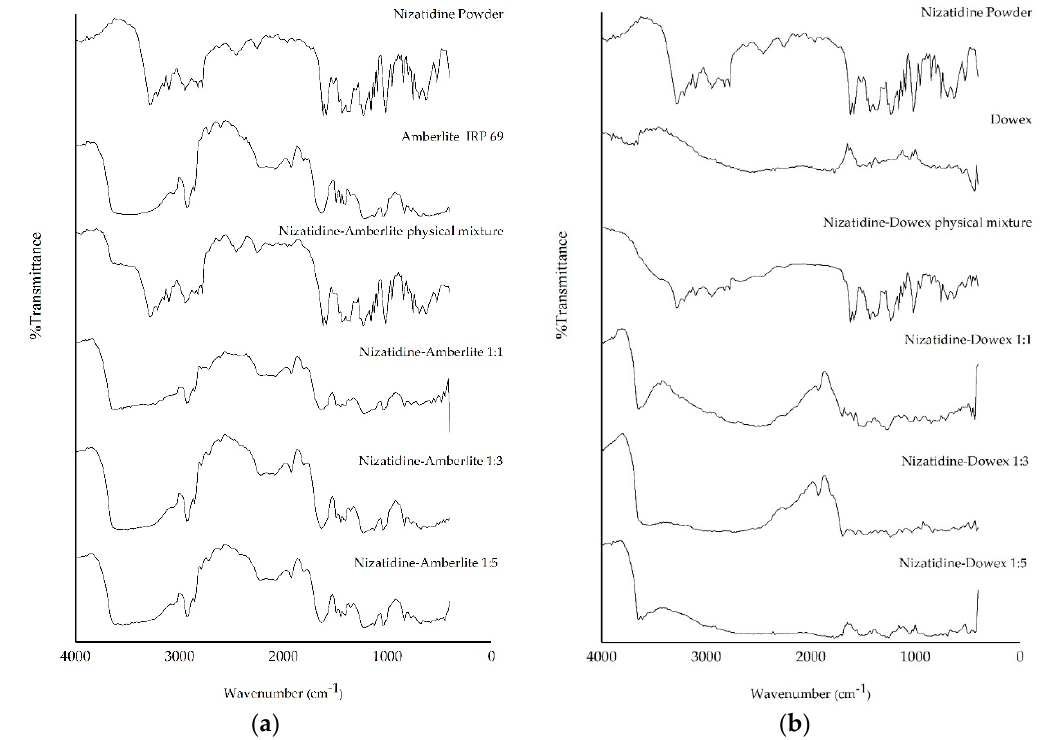
Figure 3. Fourier-transform infrared spectroscopy (FTIR) spectra of NZD powder, Amberlite IRP-69 resin, a physical mixture of NZD and Amberlite and the NZD-Amberlite complex at ratios of 1:1, 1:3, and 1:5 ( a ) and NZD powder, Dowex 50w resin, a physical mixture of NZD and Dowex and the NZD-Dowex complex at ratios of 1:1, 1:3, and 1:5 ( b ).